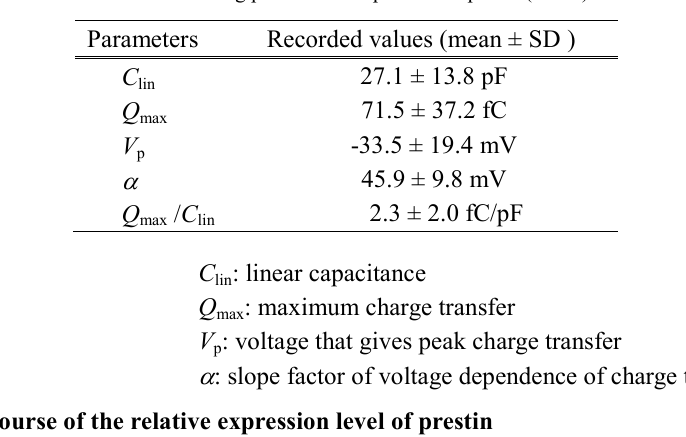
Fig. 3 Representative data of membrane capacitance versus membrane potential. Recorded data points are fitted to Eq. (1), which is shown by the solid line. Fitting parameters are C lin = 34.9 pF, Q max = 55.7 fC, V p = -30.6 mV and α =50.5 mV. Charge density = 1.6 fC/pF. Table 1 Fitting parameters of patch-clamp data (n